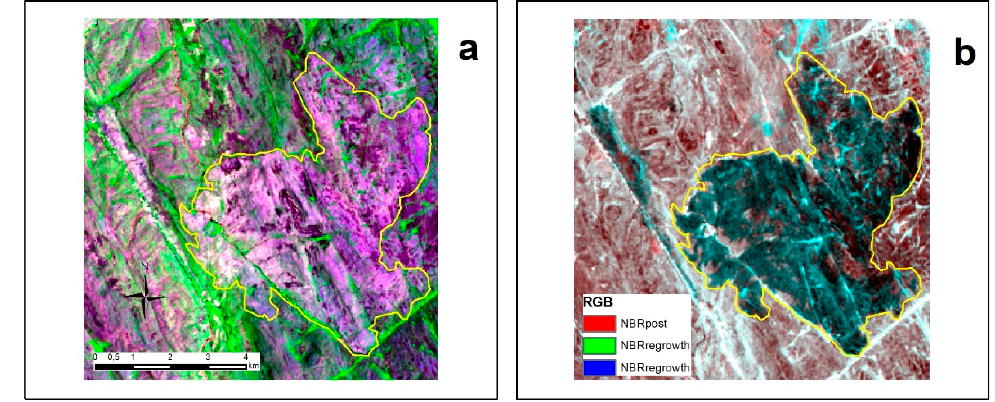
Figure 9. Pictures of: ( a ) colored composition image corresponding to the regrowth area for the fire near Mucugê, data from the OLI Landsat-8 7-5-4 RGB OLI sensor and ( b ) multitemporal visualization of the regrowth area (2016) corresponding to the Mucugê fire, RGB NBRpre, NBRpost, and NBRregrowth.